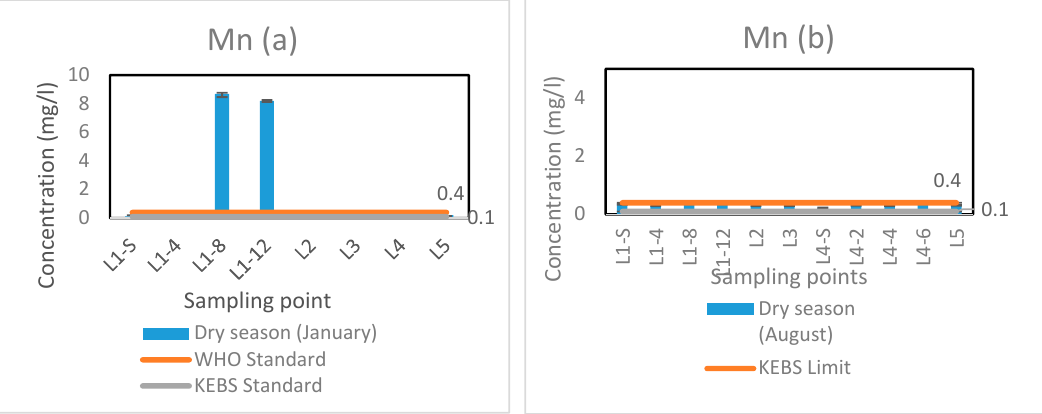
Figure 10. Cadmium concentration at various sampling points during the dry season: ( a ) January and ( b ) August.